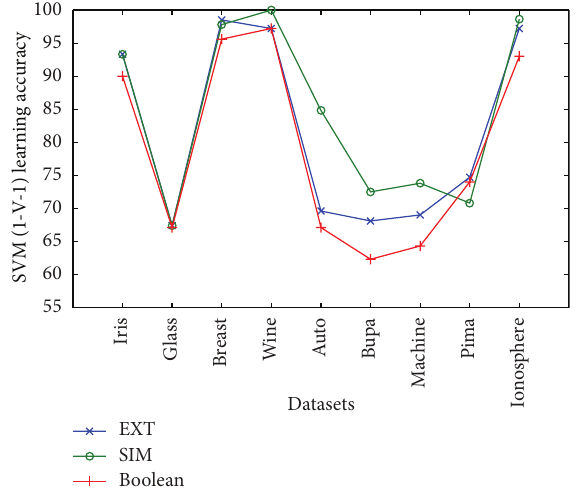
Figure 3: Comparison of SVM (1-V-1) performance on 9 UCI real datasets.